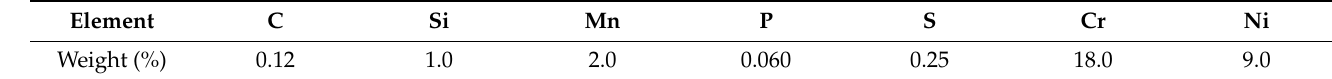
Table 1. Typical AISI 303 chemical composition and weights.